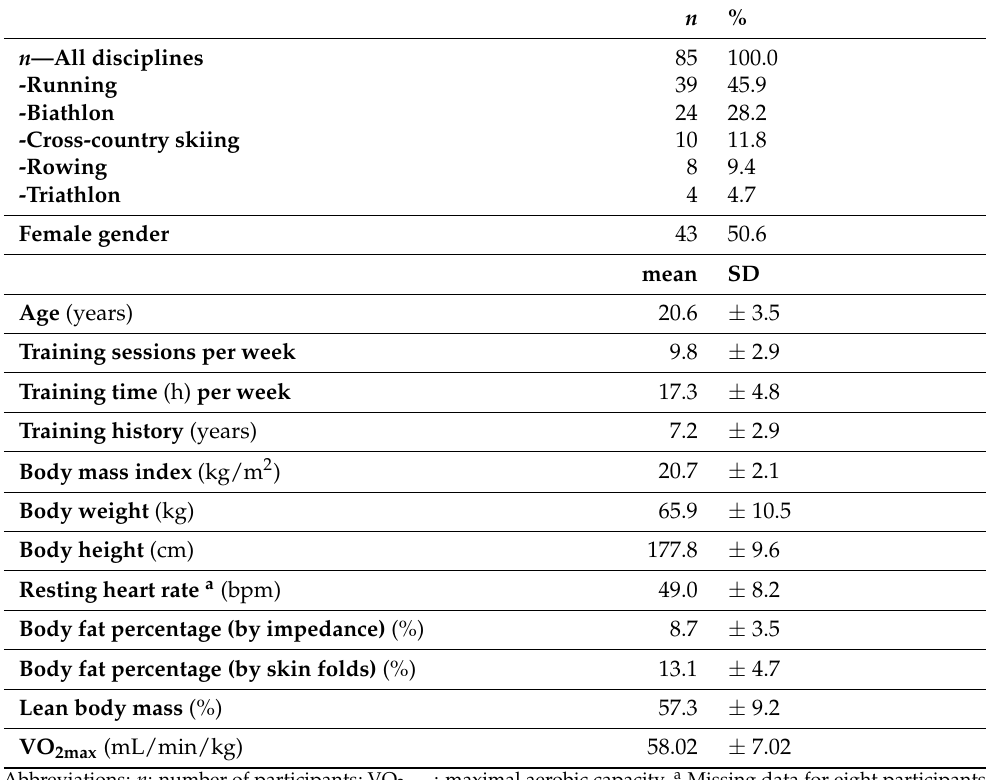
Table 1. Characteristics of the athletes (entire